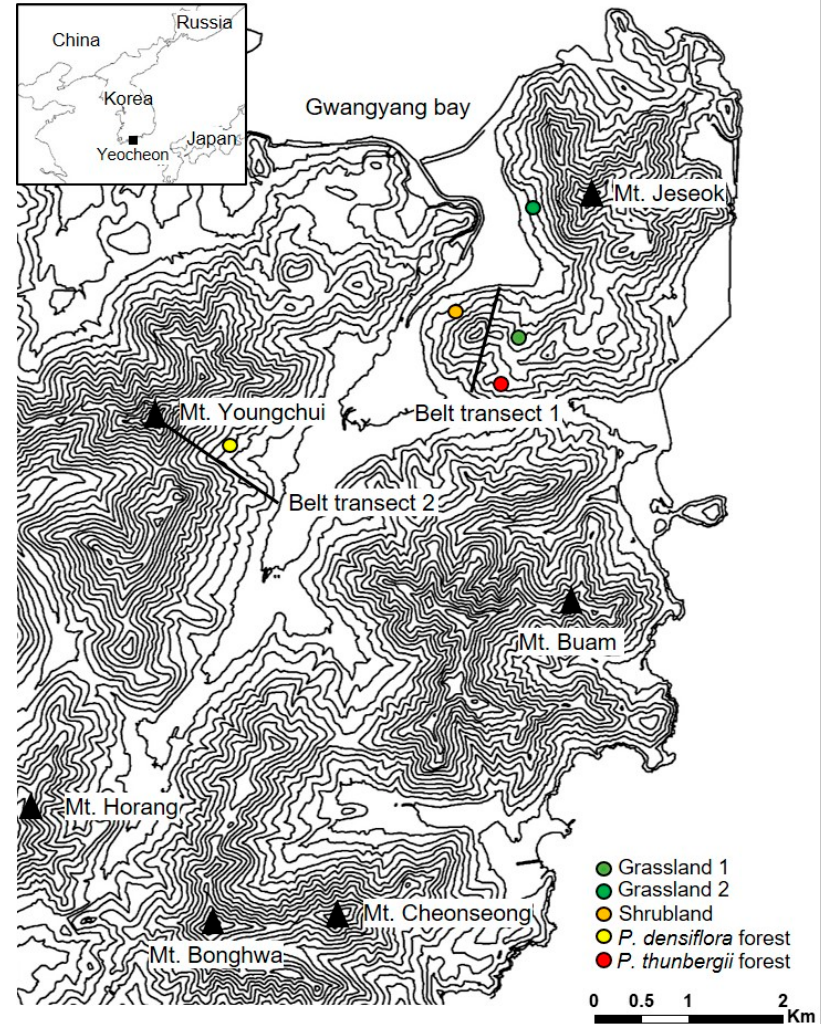
Figure 1. A topographic map showing the locations of belt transects and plots installed for the vegetation survey in the study area, Yeocheon industrial complex.